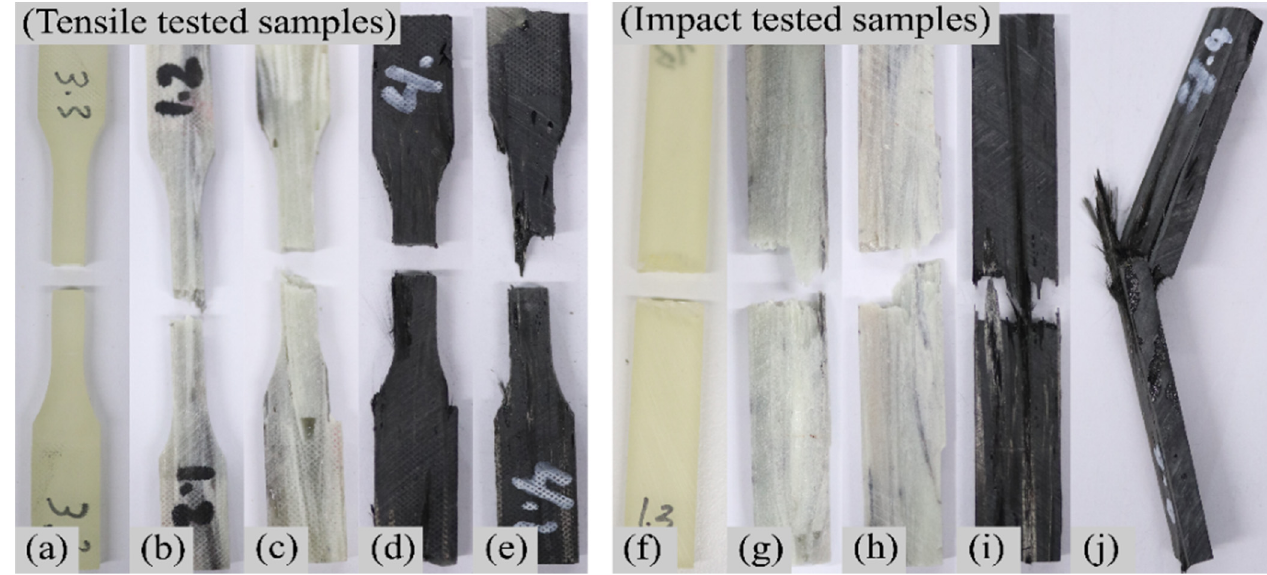
Figure 3. Sample fracture after experimental TT: ( a ) 100% EP; ( b ) 40% rGF/EP; ( c ) 60% rGF/EP; ( d ) 40% rCF/EP; ( e ) 60% rCF/EP; and after IT: ( f ) E-EP; ( g ) 40% rGF/EP; ( h ) 60% rGF/EP; ( i ) 40% rCF/EP; ( j ) 60% rCF/EP.